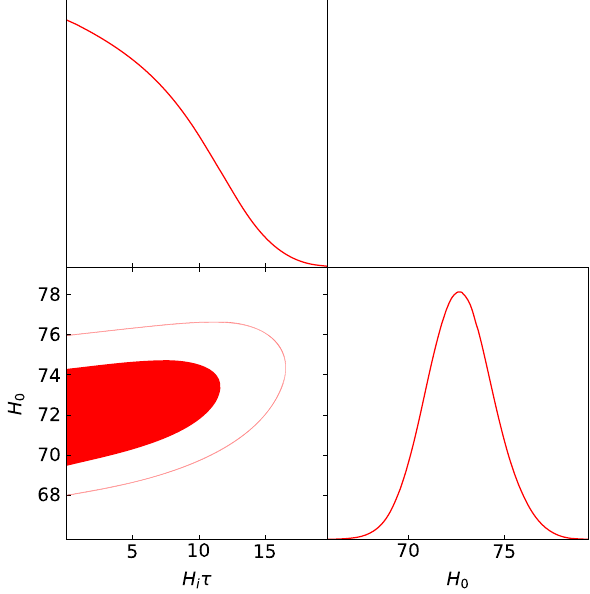
Fig. 13 Marginalized posterior distributions of the time delay param- eter τ and the Hubble constant H 0 using Hubble data. The median esti- mate is H i τ = 5 . 63 + 4 . 97 − or τ = 0 . 0998 + 0 . 0890 − Gyr, while the median 0 . 0703 3 . 95 estimate for the Hubble constant is H 0 = 72 . 67 ± 1 . 72 km s − 1 Mpc −